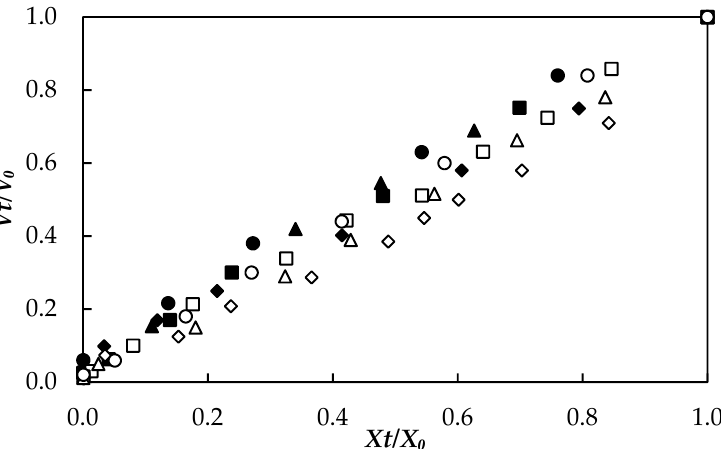
Figure 4. Relationship between volume change and moisture content during drying of Aloe vera gel slabs with 5 mm (60 °C, ♦ ; 70 °C, ■ ; 80 °C, ▲ ; 90 °C, ● ) and 10 mm (60 °C, ◊ ; 70 °C, □ ; 80 °C, ∆ ; 90 °C, ○ ) thickness.